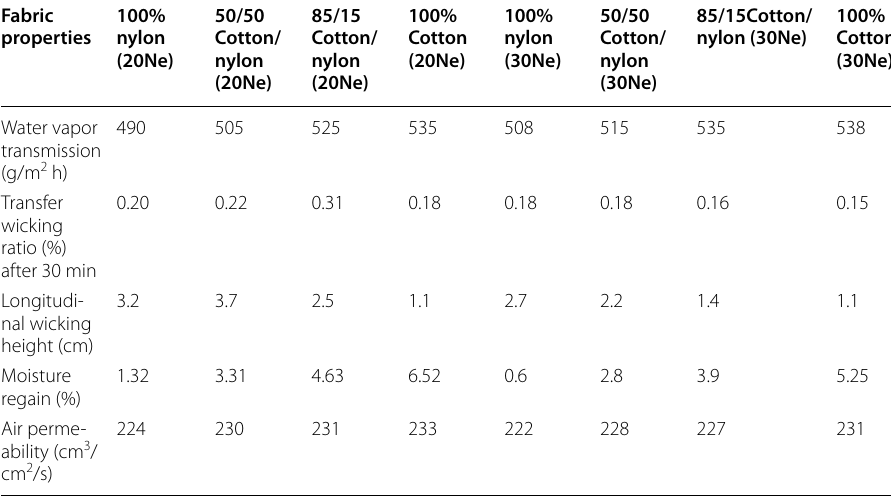
Table 3 Test results of transmission properties of the different fabric samples Fabric